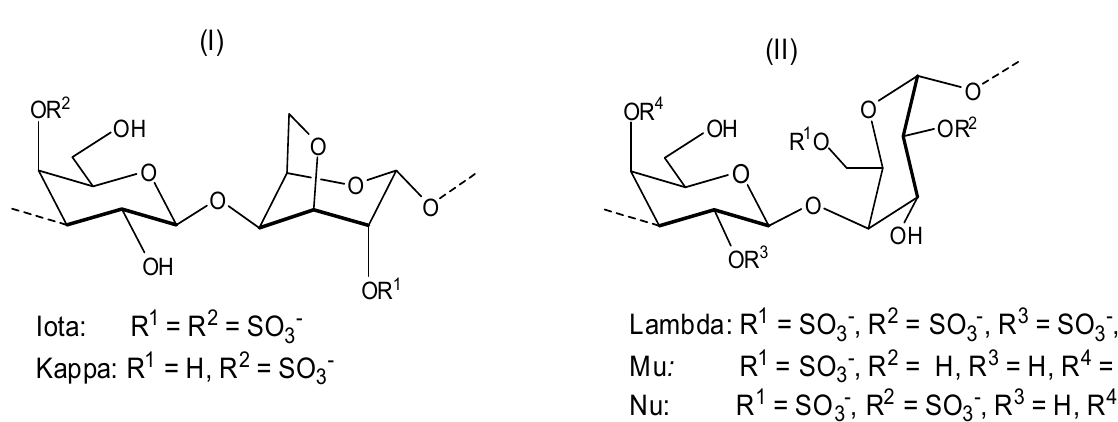
Figure 3. Repeating structures of